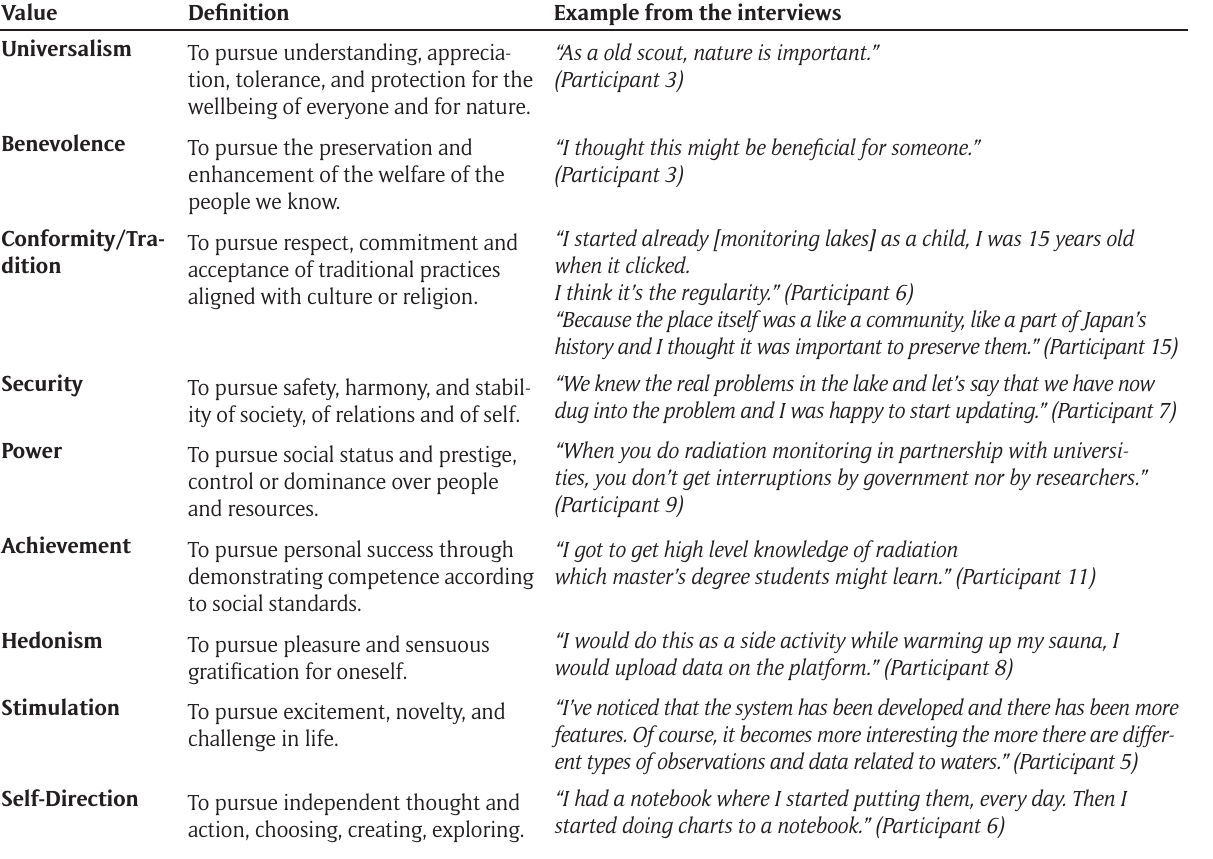
Table 2: Basic human values defined by Schwartz (Schwartz 2003), with examples extracted from the